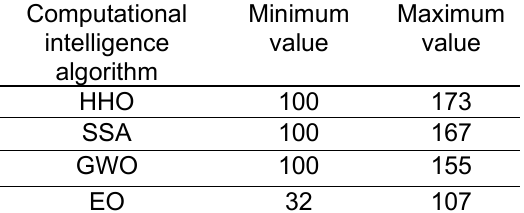
Table 4. Minimum and maximum number of localized nodes of computation intelligence